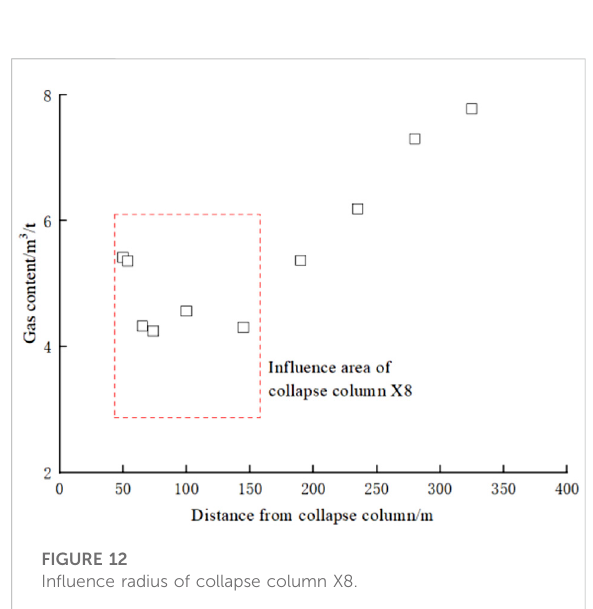
FIGURE 12 In fl uence radius of collapse column